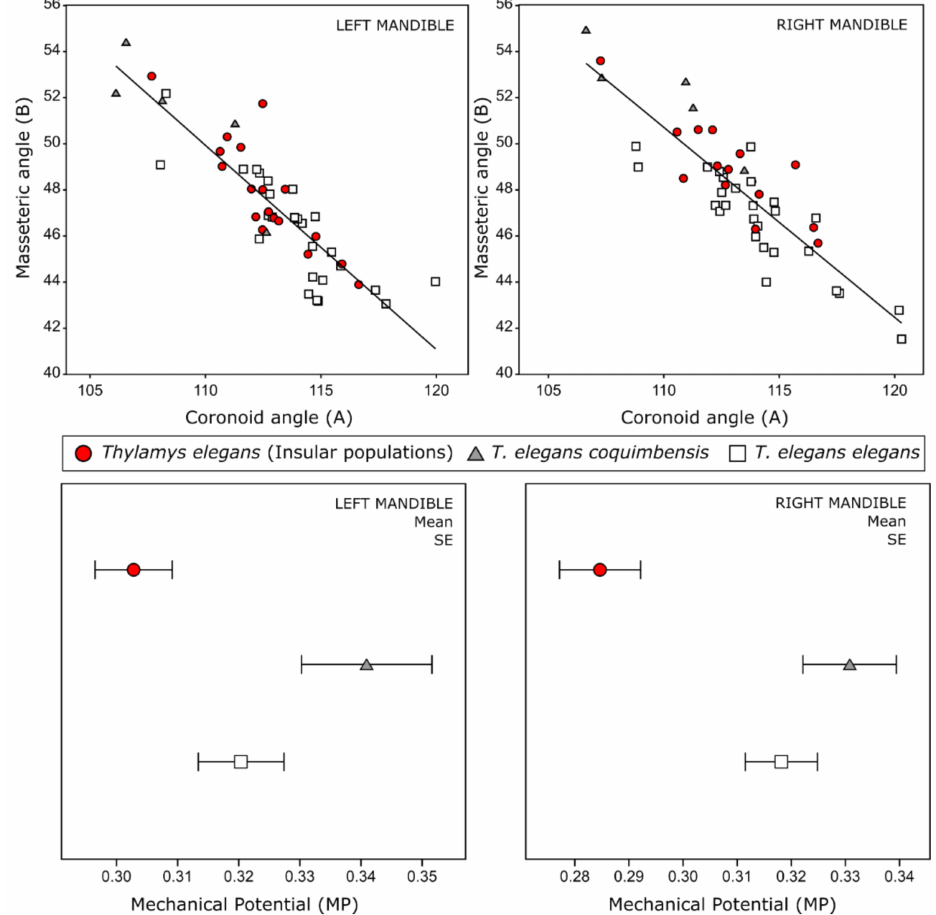
Figure 5. ( Top row) Linear regressions between Angle A and Angle B for each hemimandible. ( Bottom row) Mechanical potential mean values and standard error in the three groups